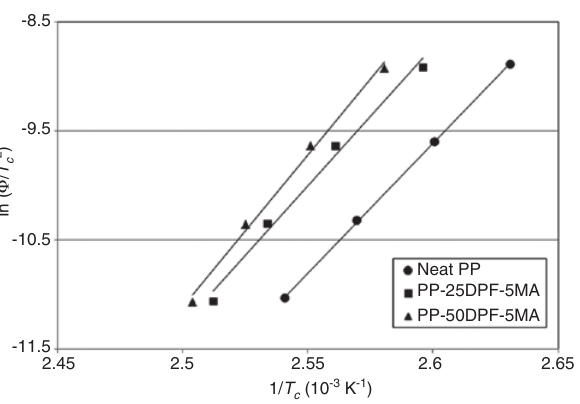
Figure 7: Determination of the overall activation energy ( Δ E ) in the neat polypropylene (PP) and PP-date palm fiber (DPF) composites by Kissinger method.